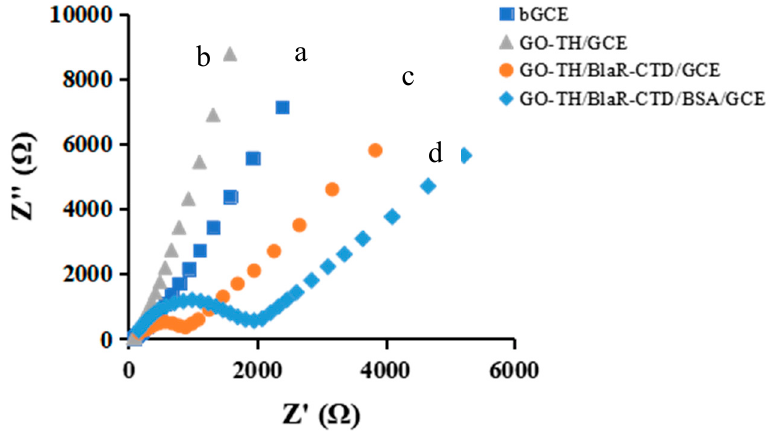
Figure 2. The electrochemical impedance spectroscopy (EIS) diagram of electrode in self-assembly process.